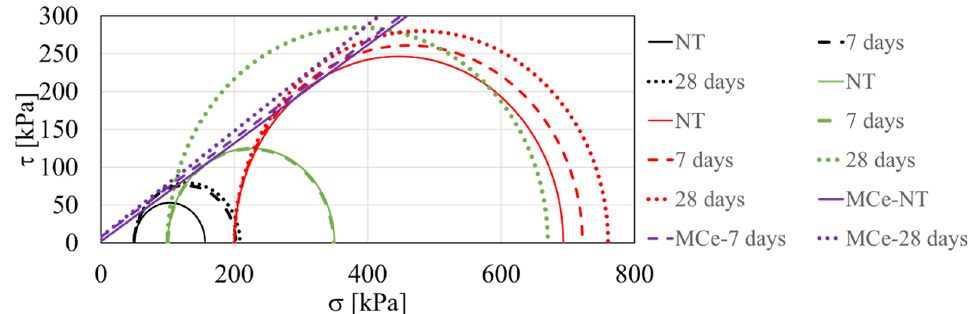
Figure 10. Mohr envelopes of peak